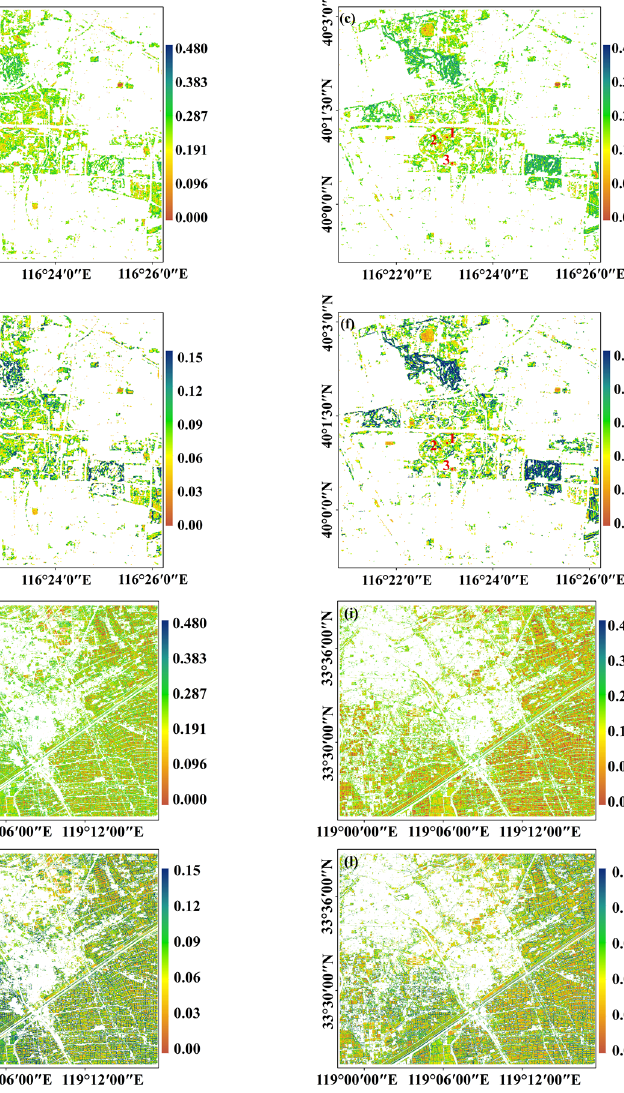
Figure 3. Spatial distributions of the RSPD and CV where ( a – c ) are RSPD in Case I on 28 August 2016, 5 September 2018, and 19 September 2020, respectively; ( d – f ) are CV in Case I on those days. ( g – i ) are RSPD in Case II on 26 July 2016, 9 September 2018, and 3 September 2020, respectively; ( j – l ) are CV in Case II on those days.